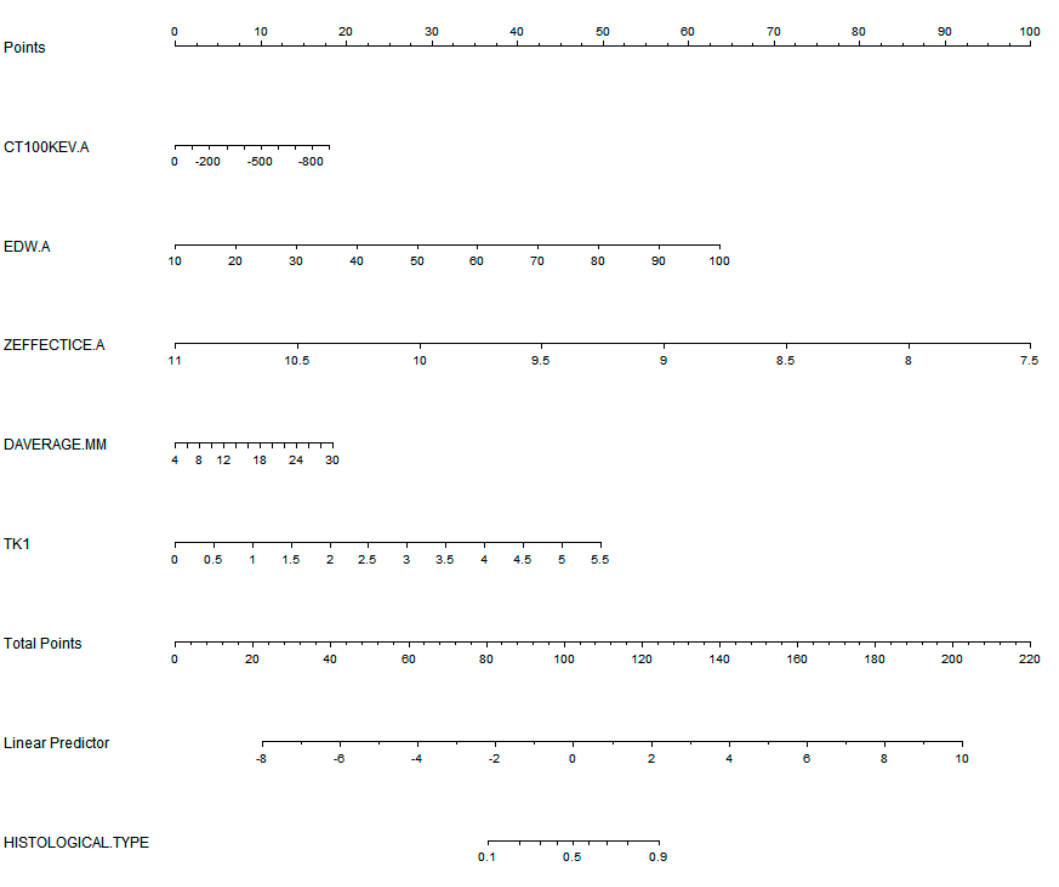
Figure 5. Nomogram created by combining the parameters predicting ground-glass nodules (GGN) featured lung adenocarcinoma invasiveness. Zeff, effective atomic number; EDW, electron density; TK1, thymidine kinase-1. Table 5. Comparison of the diagnostic efficiency of the diagnostic models based on SDCT parameters and TK1.